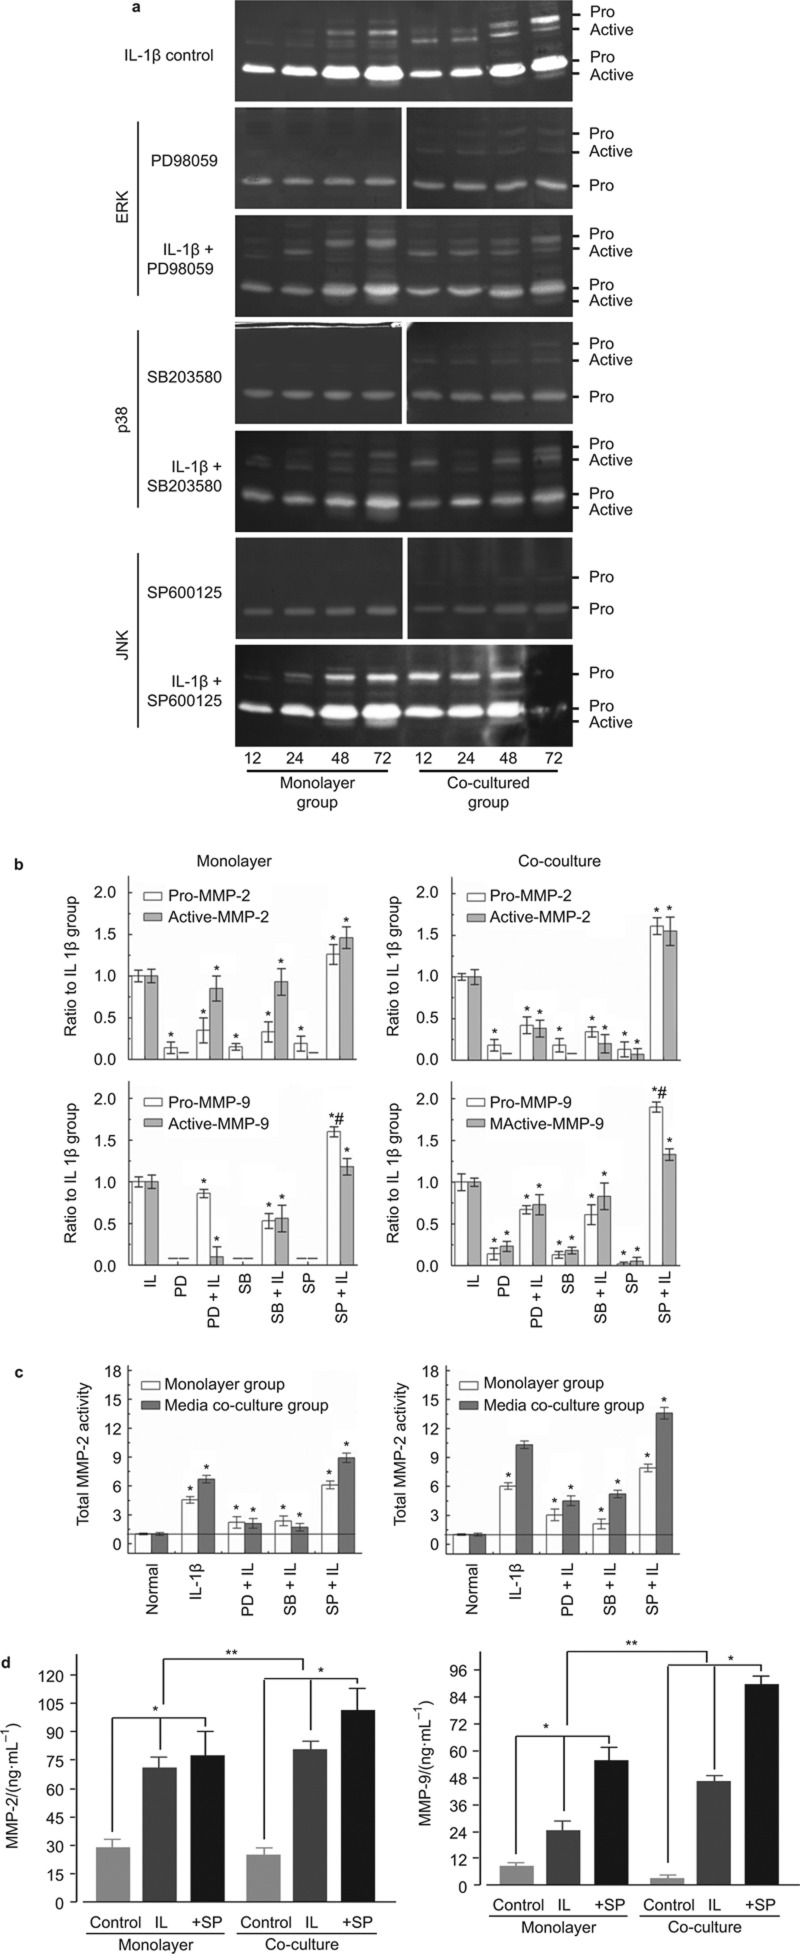
IL-1β restores the high activities of gelatinases in MAPK-specific inhibitor-pretreated mono-cultured and co-cultured chondrocytes. (a) Zymography demonstrating that IL-1β (10 ng·mL−1) can restore the activities of gelatinases through ERK (in the presence of PD58059), p38 (in the presence of SB203580) and especially JNK (in the presence of SP600125). The gels shown are representative of three different experiments (n = 3). (b) The activities of pro- and active-MMP-2/9 in mono-cultured and co-cultured chondrocytes were quantified by the optical densities methods (Quantity One 4.6.3 software). The indicated quantitative data refer to 72 h time-points. The data are the mean of three different experiments (n = 3). *Significant difference with respect to IL-1β-induced control (P < 0.05); #Significant difference with respect to other two inhibitor-treated groups (P < 0.05). (c) IL-1β restored the total activities of gelatinases in MAPK inhibitor-pretreated chondrocytes (mean ± standard deviation) (n = 3). Scale bars, standard deviation. *P < 0.05, compared with control. (d) Due to high restored gelatinases in JNK inhibitor group, ELISA was done to explore the gelatinase secretion in both mono-culture and co-culture groups (mean ± standard deviation) (n = 4). *P < 0.05, **P < 0.025, compared with controls. ELISA, enzyme linked immunosorbent assay; ERK, extracellular signal-regulated kinase; IL, interleukin; JNK, c-Jun N-terminal kinase; MMP, metalloproteinase.